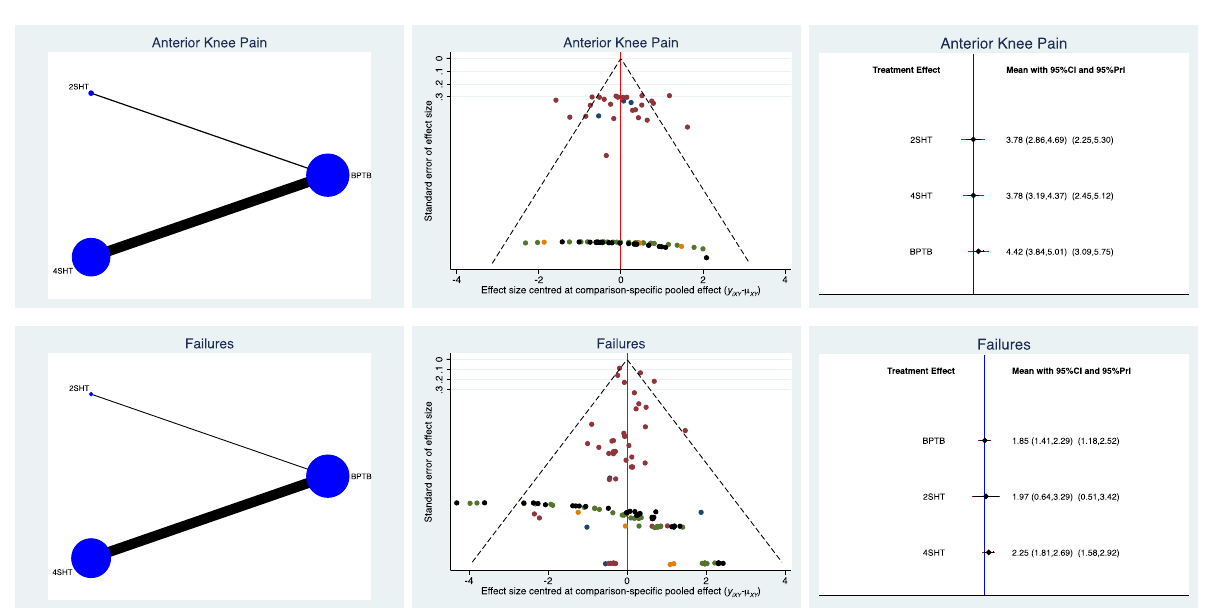
Figure 5. Edge, funnel, and interval plots of the network comparisons: complication.